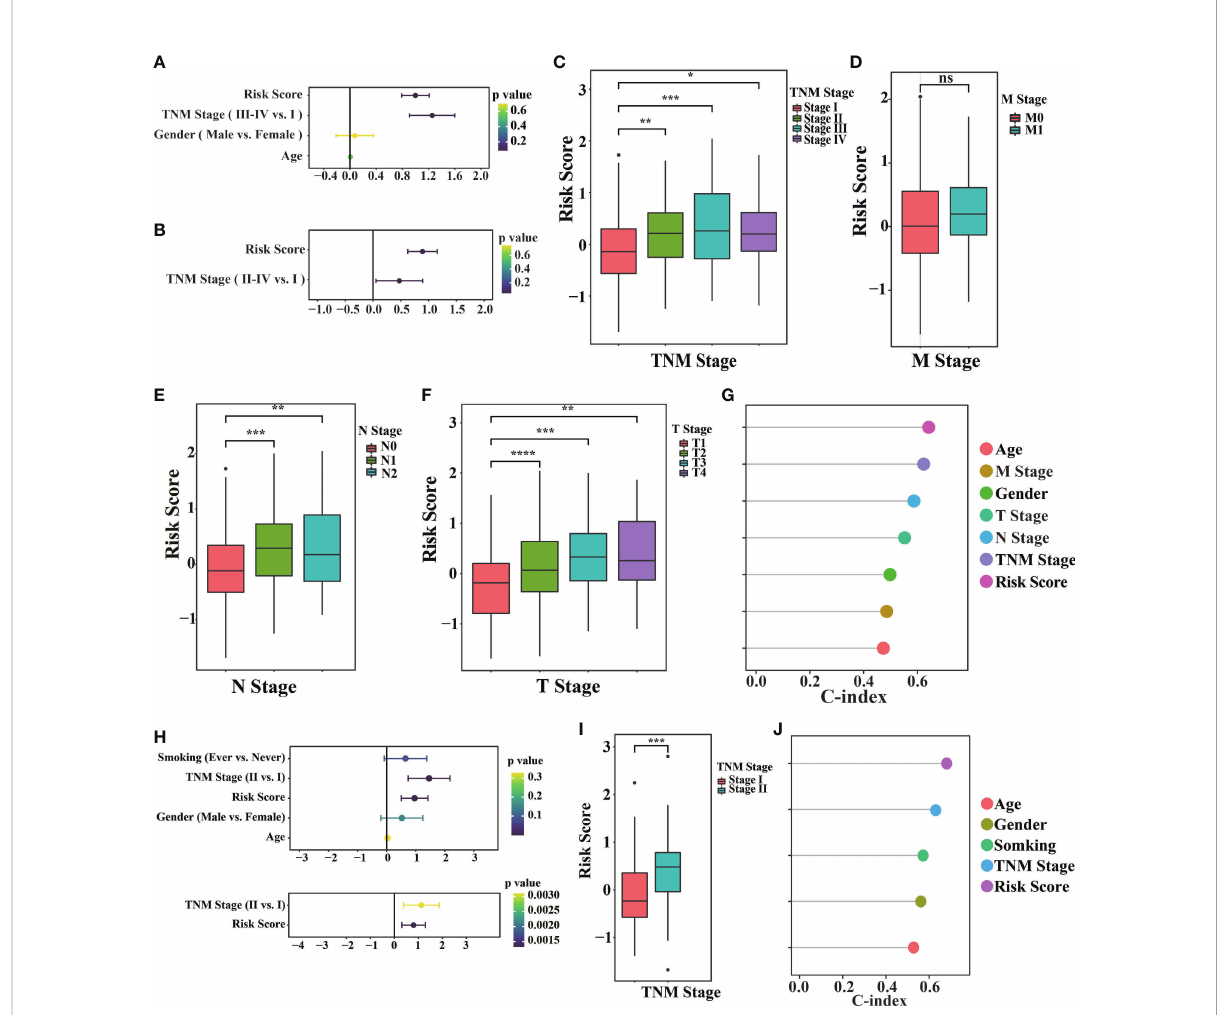
FIGURE 3 Prognostic values of the model in TCGA and GEO cohorts. (A) The TCGA-LUAD primary cancer samples, corresponding clinical records and corresponding risk score (n = 520) were used for univariate Cox regression. (B) Perform multivariable Cox regression on the signi fi cant factors in univariate Cox regression. (C – F) TCGA-LUAD samples with different tumor traditional clinical stage (TNM stage, M stage, N stage, T stage) and their corresponding risk scores. (G) Consistency index of TCGA-LUAD primary cancer samples, corresponding clinical records and corresponding risk score (n = 520) calculated by univariate Cox regression. (H) Using univariate Cox regression (above) in the GSE31210 cohort (n = 246), the signi fi cant factors in univariate Cox regression are performed in multivariable Cox regression (below). (I) samples with different TNM stages in GSE31210 cohort and their corresponding risk scores. (J) The consistency index of primary cancer samples, corresponding clinical records and corresponding risk scores in GSE31210 cohort was calculated by univariate Cox regression. ( “ ns ” is non-signi fi cant, *P< 0.05, **P< 0.01, ***P< 0.001, ****P<